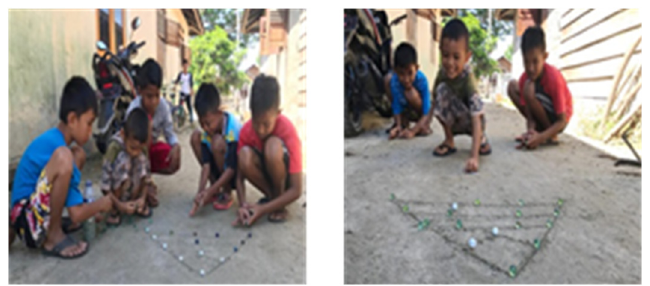
Figure 2. Kaniker molega.